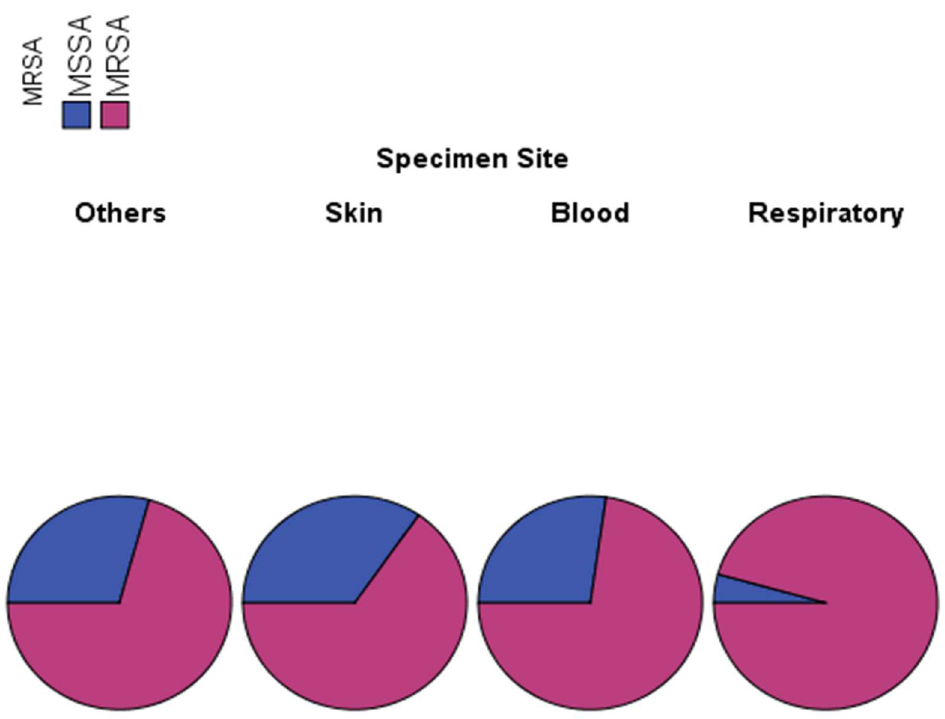
Figure 3. Frequencies of MRSAs and MSSAs rates on the skin and different specimen sites in Ha’il region, Saudi Arabia. Abbreviations/A- not available; MRSA—Methicillin-resistant Staphylococcus aureus; MSSA—Methicillin-sensitive Staphylococcus aureus. Table 3. Association rates between site of infection on different specimen and MRSA and MSSA lineages in Ha’il region, Saudi Arabia.